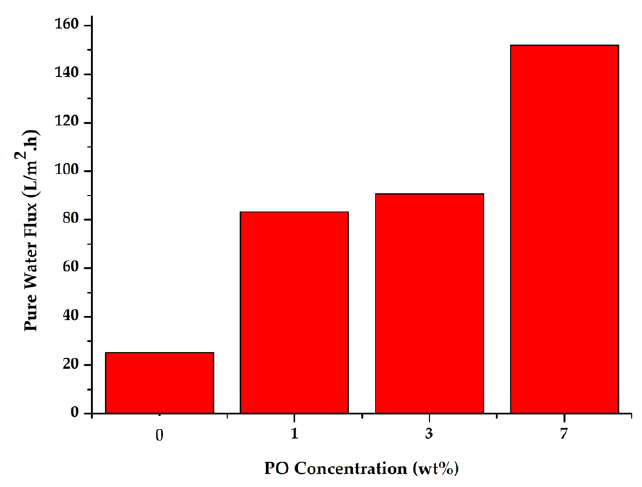
Figure 7. Water flux of the membrane prepared with various addition of PO.